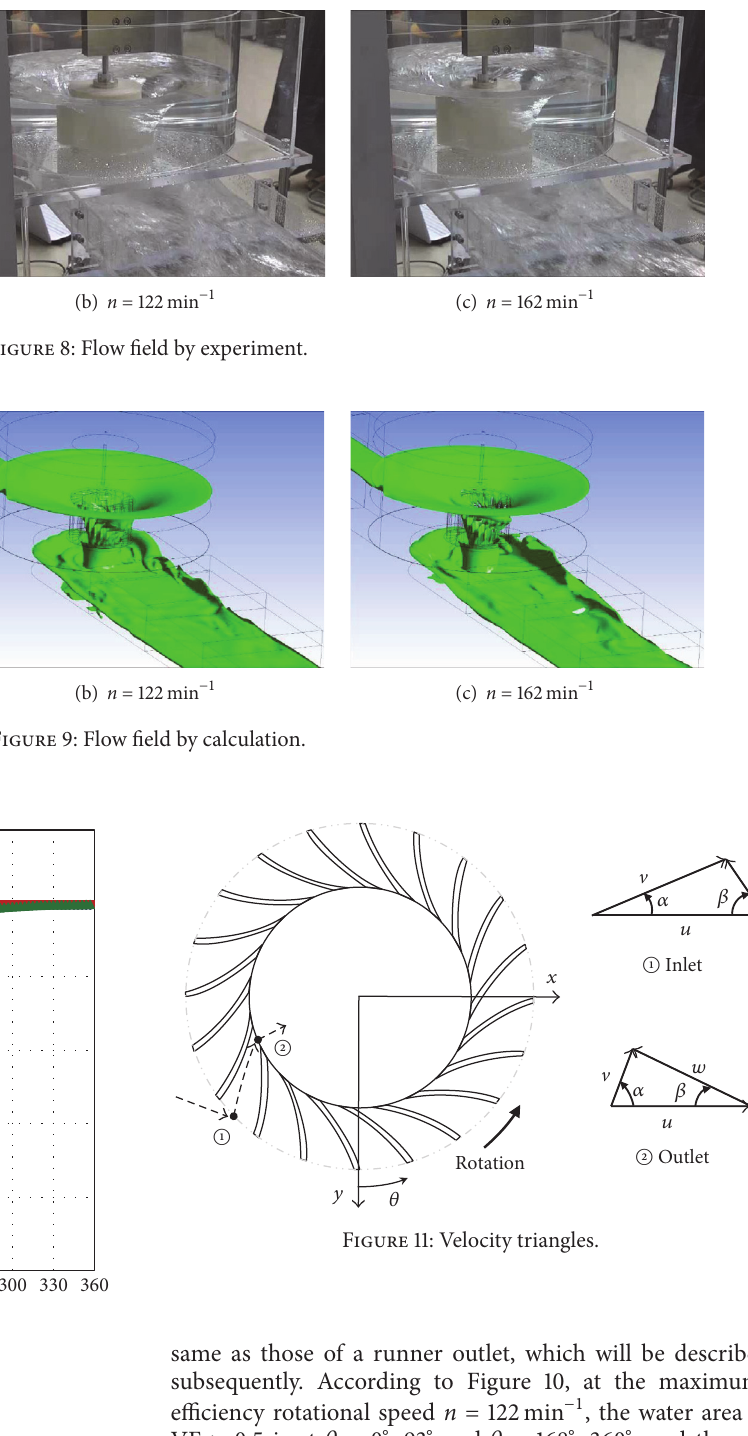
Figure 10: Volume fraction of water at runner inlet (Cal.).